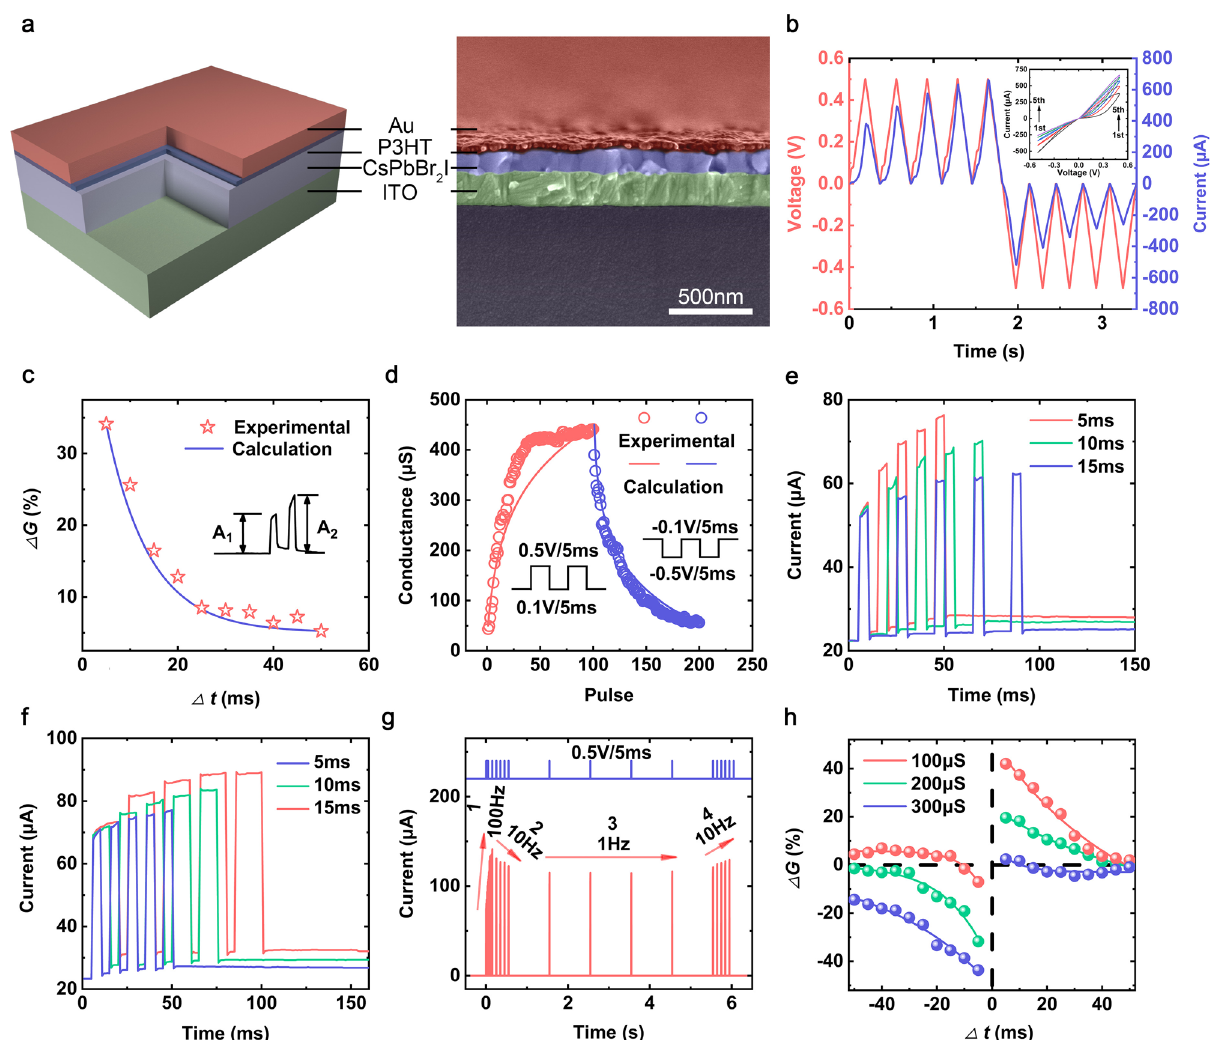
Fig. 2 | Emulation of arti fi cial synapses. a The schematic and the cross-sectional SEM image ofAu/P3HT/CsPbBr 2 I/ITO memristor. b The current withrespect to DC voltage sweeps, the device conductance gradually increase (decrease) under positive (negative) sweeps of 0.5V ( − 0.5V). c The PPF ratio as a function of pre- synaptic pulse interval which can be expressed as ð A 2 (cid:1) A 1 Þ = A 1 ×100%. The pulse width and amplitude were set to 5ms and 0.5V. d The modulation of device con- ductanceasafunction of 100consecutive potentiating and 100depressing pulses.